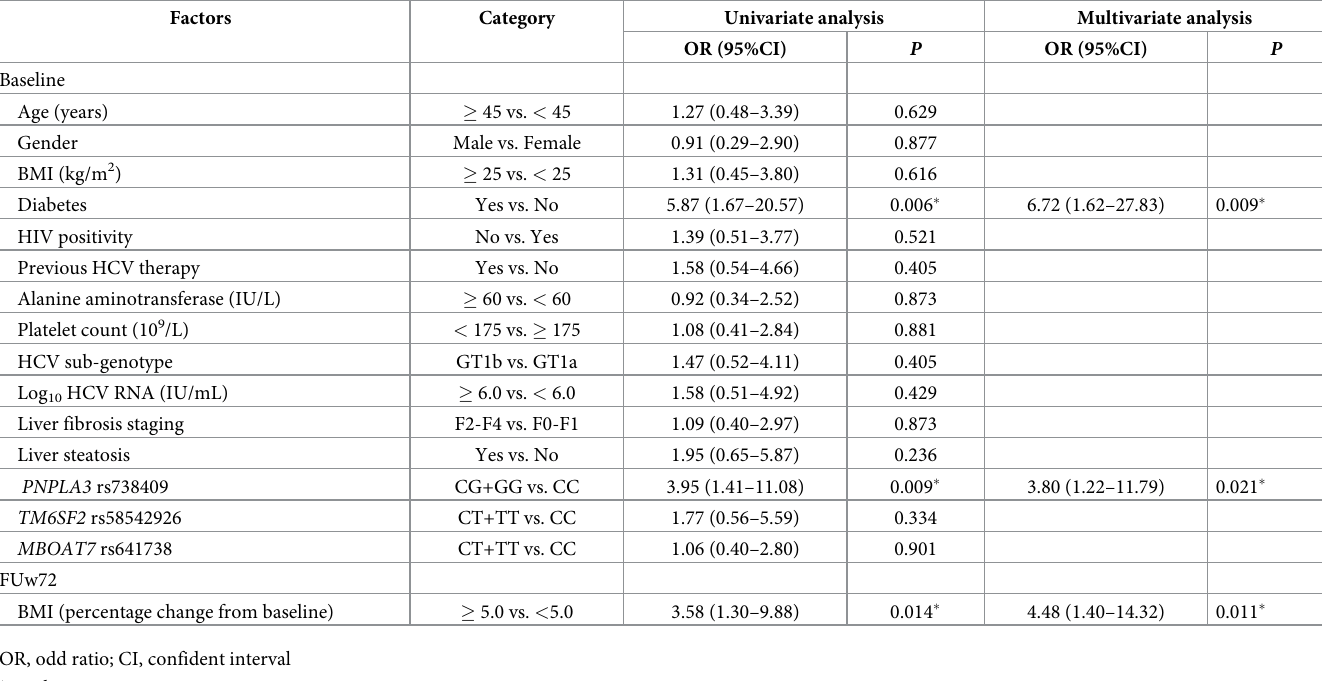
Table 3. Factors associated with increased PDFF ( � 30% from